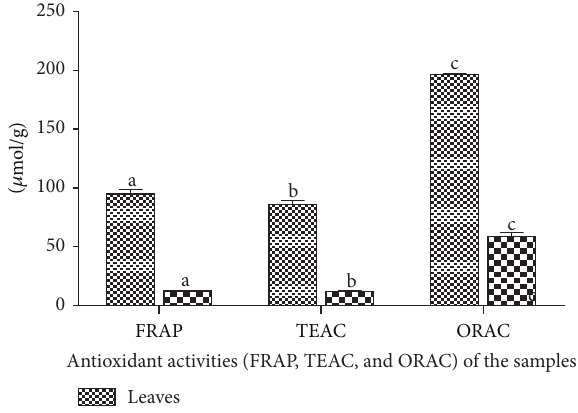
Figure 5: Antioxidant activities (FRAP, TEAC, and ORAC) in the aqueous extracts of the leaves and fruits of Nauclea latifolia. All significant differences are at 𝑃 < 0.05 . a-a,b-b,c-c Bars having the same alphabets are significantly different from each